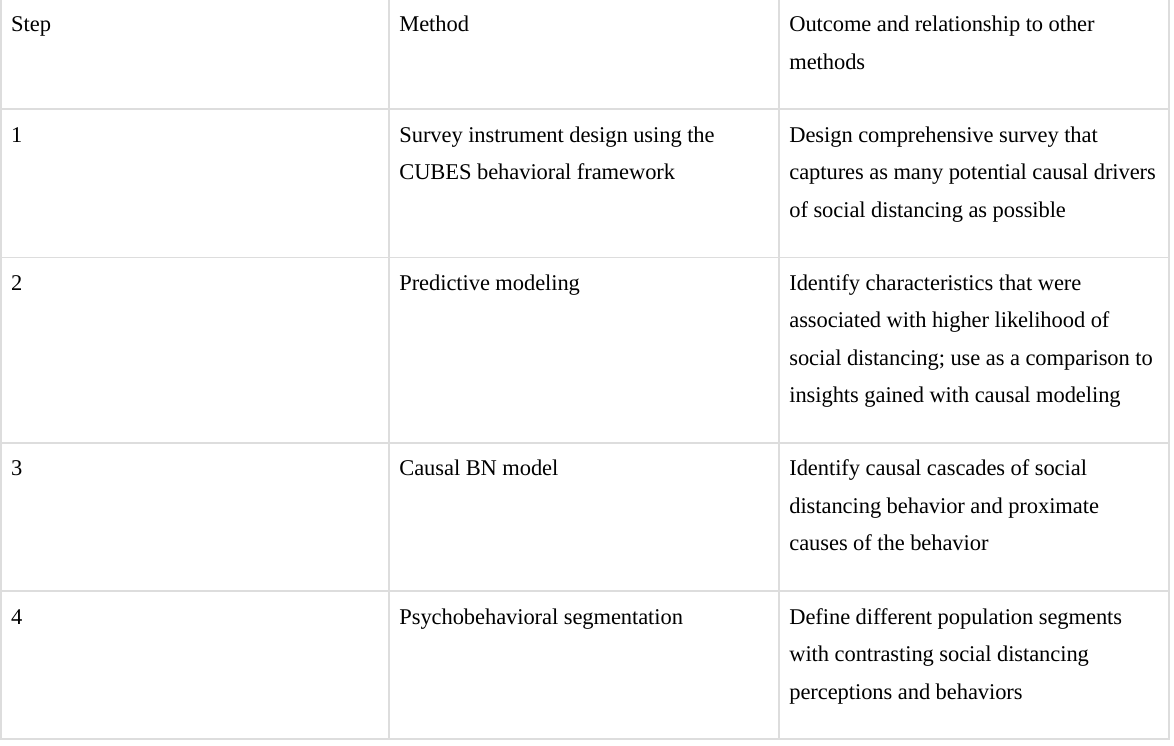
Table 1. Breakdown of methods, our reasoning for using the method, and the outcome of the